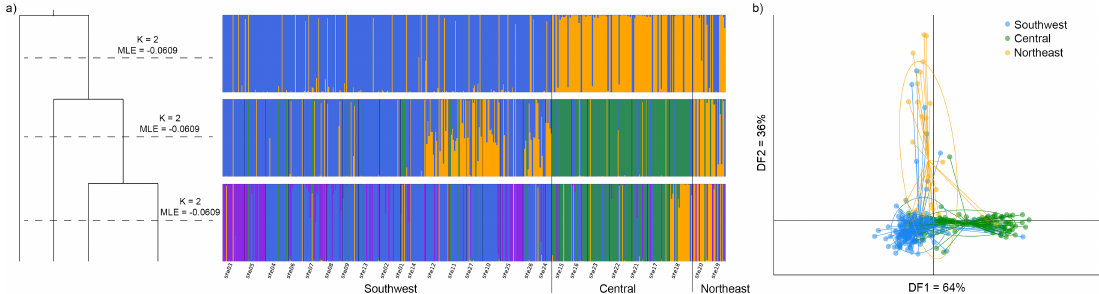
Figure 4. Group assignment and clustering outputs produced via ( a ) fastStructure showing marginal likelihoods and individual assignment to genetic clusters for K = 2–4, and ( b ) discriminant analysis of principal components (DAPC). K = 3 highlights distinction among southwest, central, and northeast regions and is consistent with fastStructure where some southwest populations show admixture with the yellow cluster dominating the northeast. Analyses were based on 3093 unlinked double digest RADseq SNPs obtained from an ipyrad assembly of 452 Sclerolaena napiformis individuals. Individuals are coloured according to region. No a priori locality information was input into either analysis.